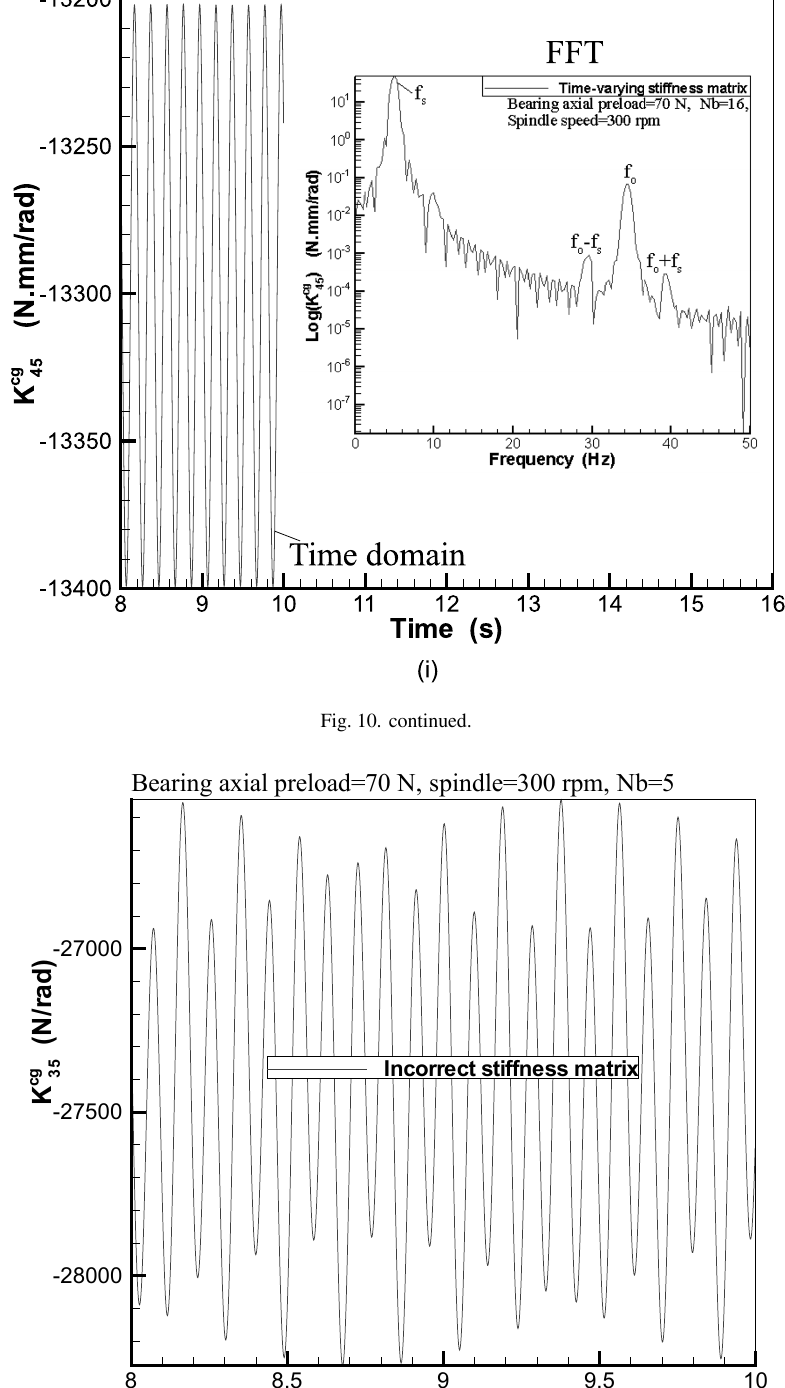
Fig. 11. Time domain of K cg 35 for the diagnoal (incorrect) total time-varying stiffness matrix ( K cg time-varying stiffness case except that the stiffness matrix is